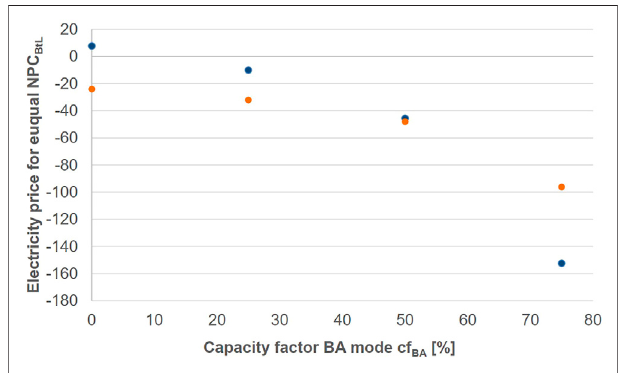
FIGURE 9 | Variation for key economic parameters applied to case 1.1 and